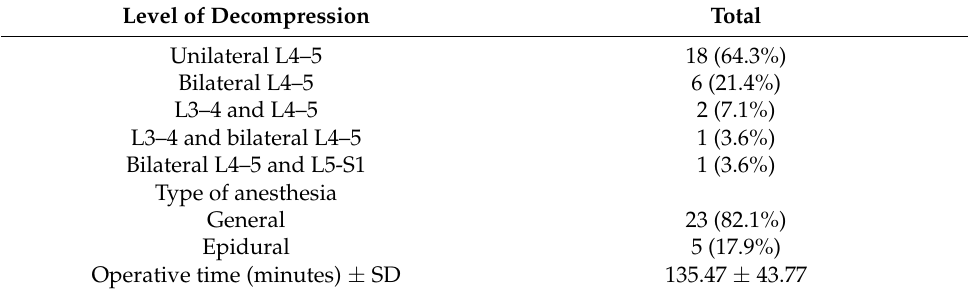
Table 2. Operative features.